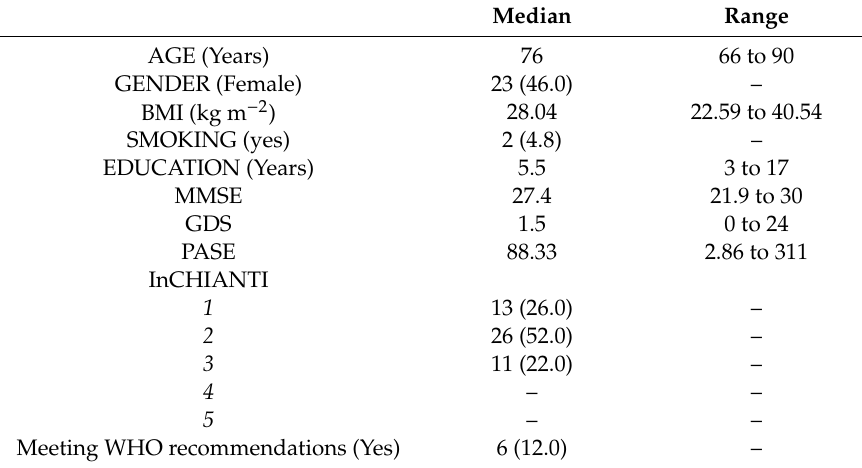
Table 1. Description of sociodemographic variables of the whole sample